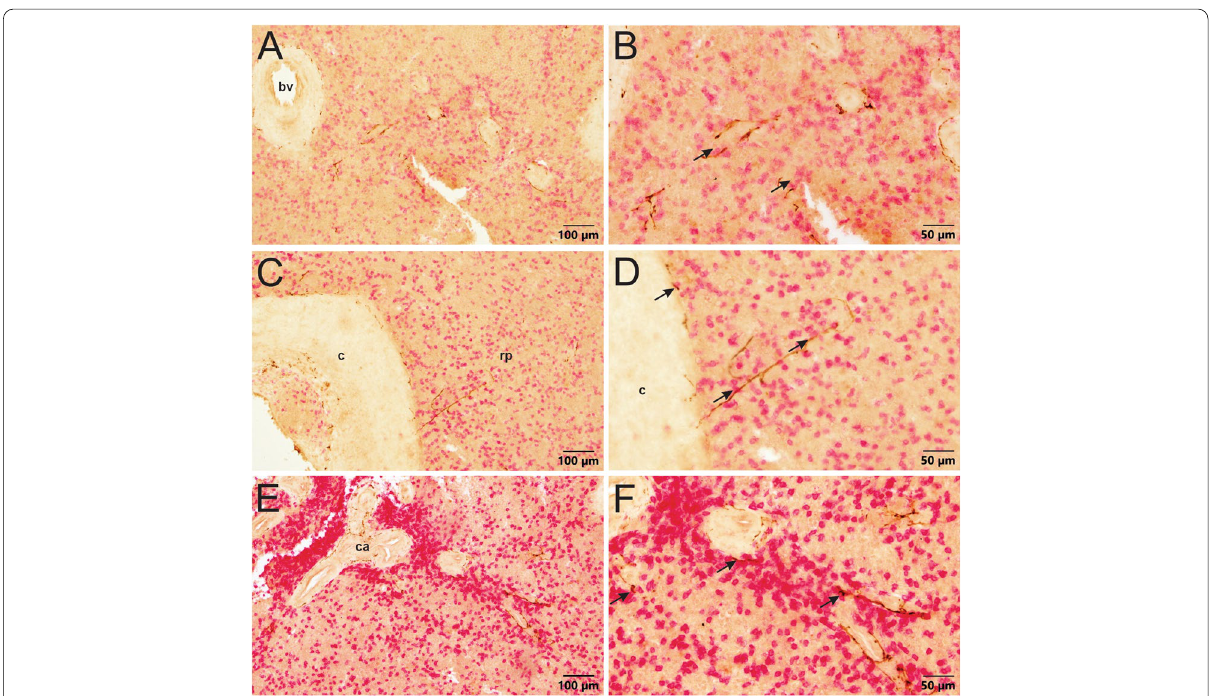
Fig. 8 Double labeling for TH (brown) and CD3 (red) in sections from donor 002 spleen. A TH nerves around blood vessels and throughout + red pulp. CD3 T leukocytes are scattered throughout the red pulp at a moderate rate. B Higher magnification image of panel A showing the + close proximity of CD3 T leukocytes with TH nerves in red pulp, indicated by arrows. C TH nerves extend from the capsule (c). D Higher + + + magnification image of panel C showing the close association of TH nerves (arrows) with CD3 T leukocytes in this subcapsular region. E CD3 + + leukocytes are densely packed around a central arteriole (ca.) cut longitudinally. TH nerves hug the blood vessels in the parenchyma. F Higher + magnification image of panel E showing the close association of CD3 T leukocytes and TH nerves around blood vessels in the + +